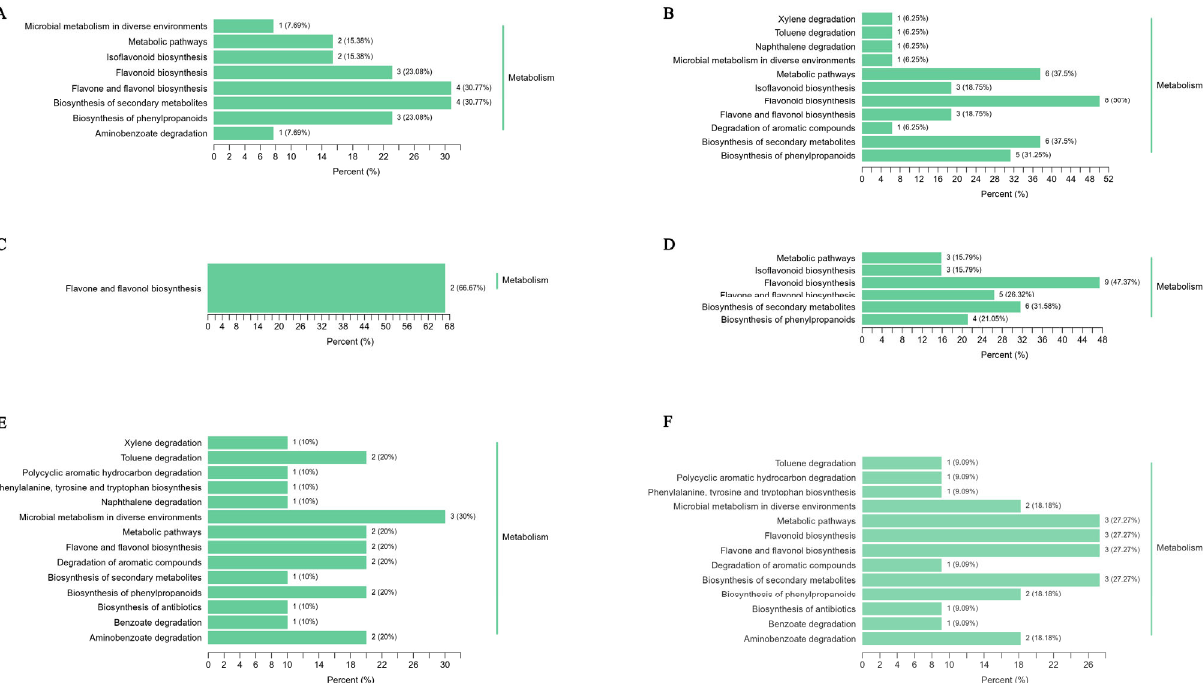
Figure 11. KEGG classification results of differential flavonoid metabolites in separate comparison pair groups. ( A – F ) Annotation results of KEGG of the flavonoid differential metabolites of A1 vs. A6, A1 vs. A2, A2 vs. A3, A3 vs. A4, A4 vs. A5, and A5 vs. A6, respectively. The abscissa is the number of metabolites annotated to this pathway and its proportion to the total number of metab ‐ olites annotated, while the ordinate is the name of KEGG metabolic pathway.